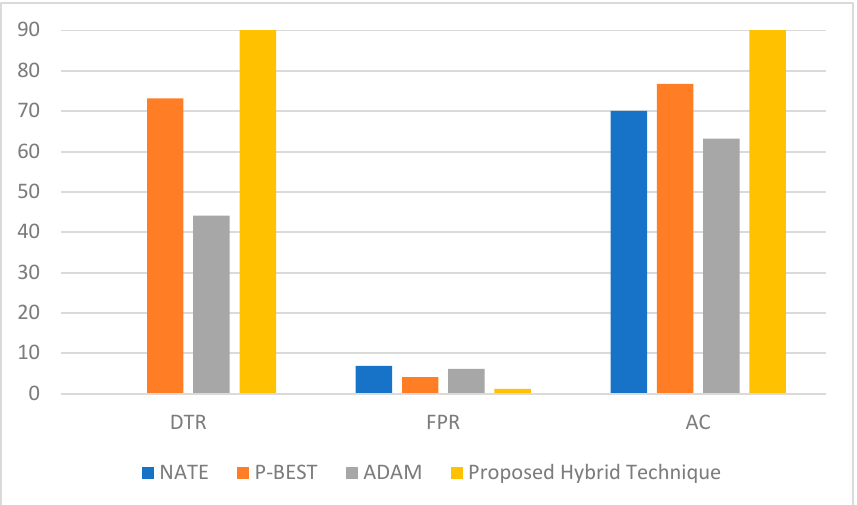
Figure 13. Comparison between the proposed hybrid algorithm and other three related works.